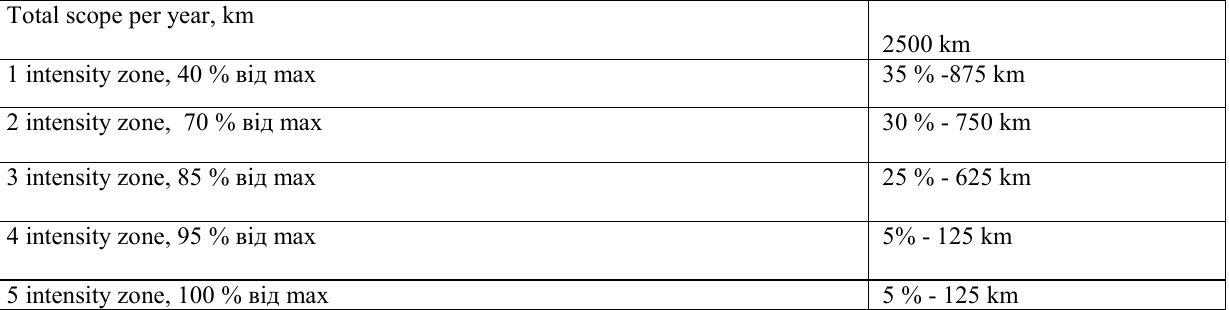
Total scope and intensity in % from “max” of targeted complex program of Ukrainian combined swimming team’s